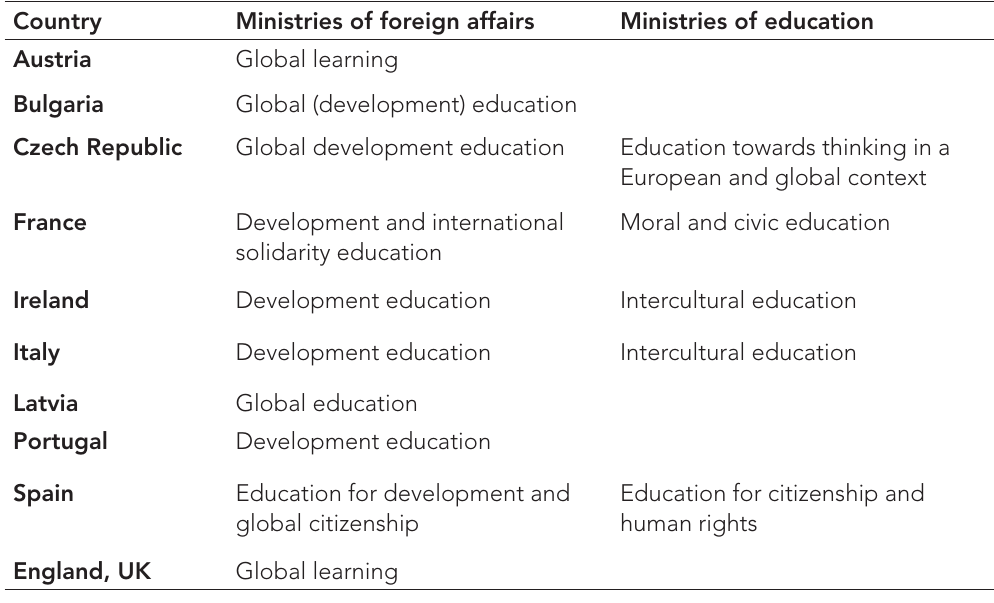
Table 2: National global citizenship education terms in different EU countries